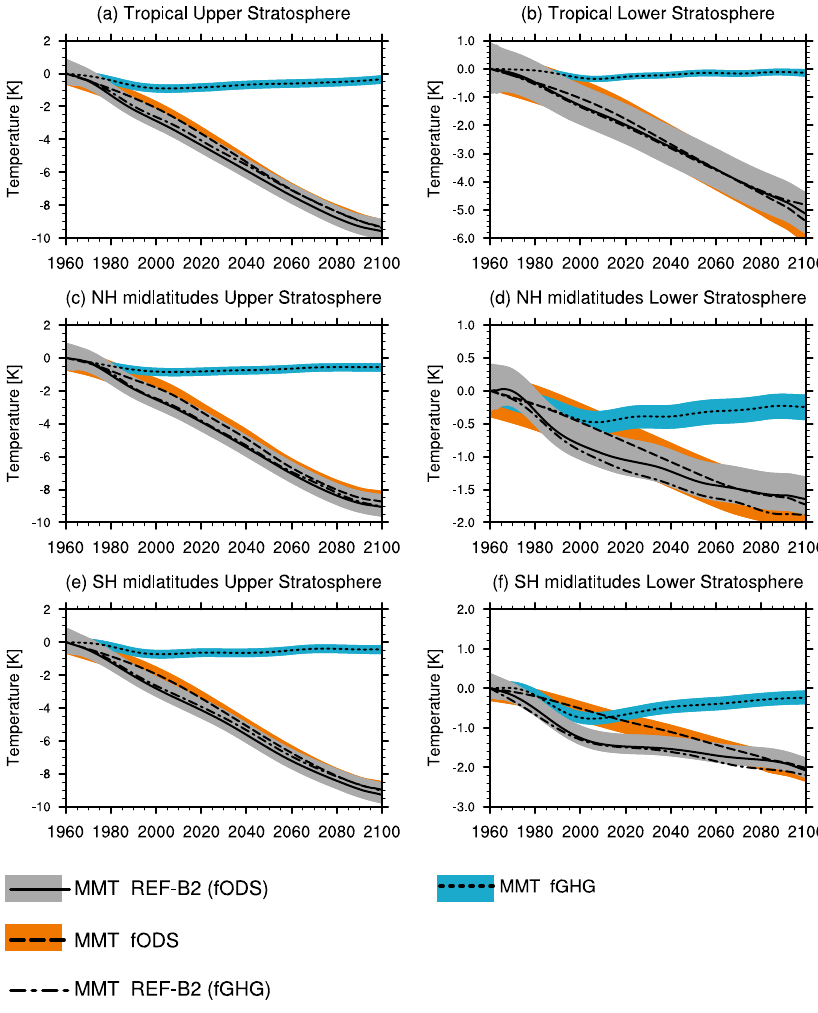
Fig. 3. Same as Fig. 2, but for